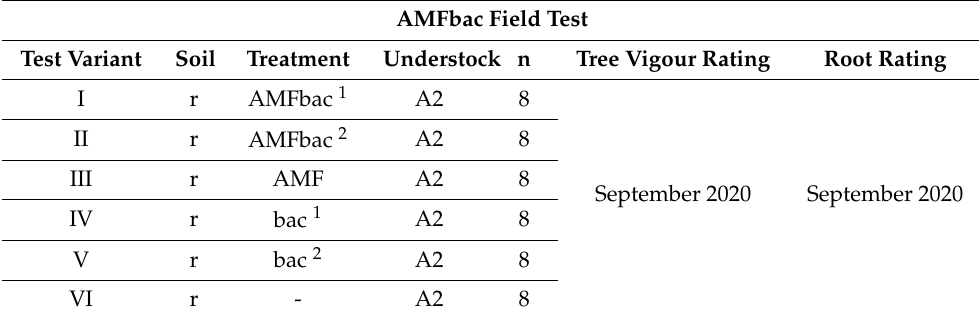
Table 6. AMFbac Field Test (April to September 2020) (18 weeks) ( n =